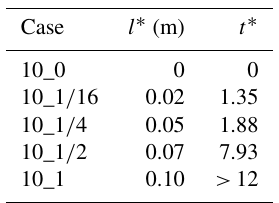
Table 4. Length scales and timescales associated with localized shear